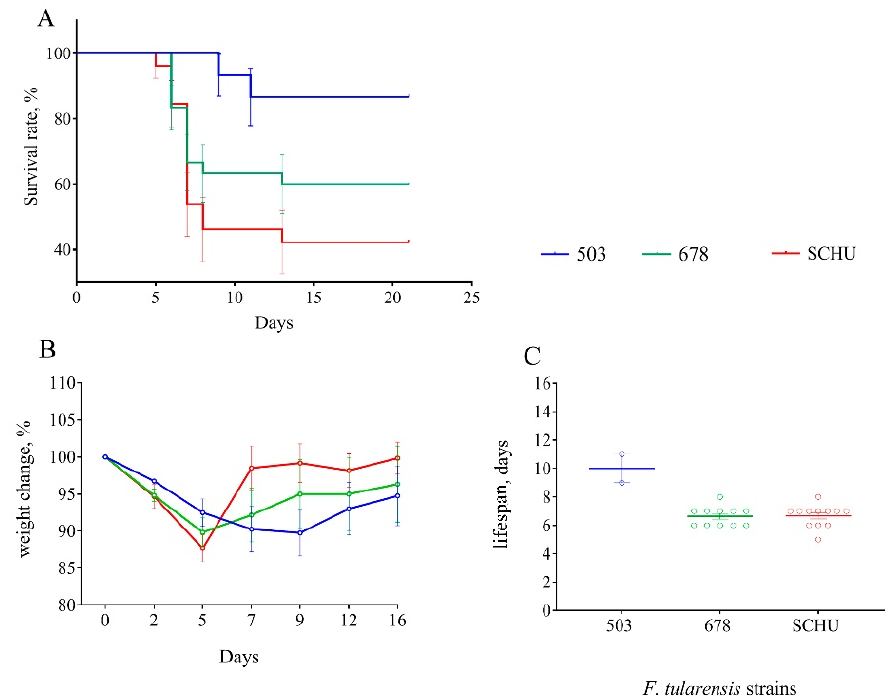
Figure 5. Survival rate ( A ), bodyweight changes ( B ), and lifespan ( C ) of mice immunized 180 days before infection with virulent strains of F. tularensis : subsp. holarctica 503, subsp. mediasiatica 678, and subsp. tularensis SCHU. Values are indicated with the standard error of the mean (SEM) for each measurement point.